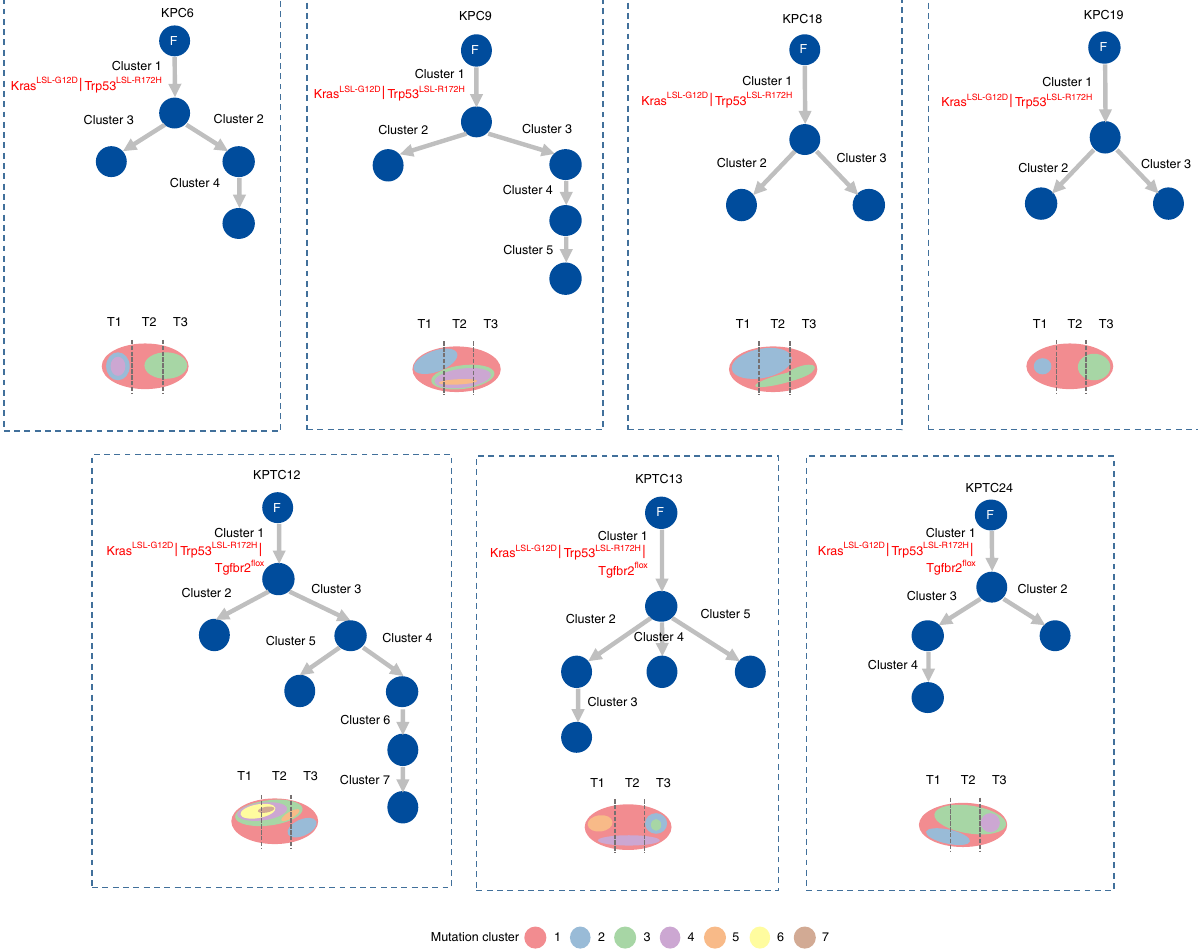
Fig. 5 Branched tumor phylogeny in KPC/KPTC mice. Seven mice had mutation cluster cancer cell prevalence values compatible with a branched evolutionary pattern. For mice KPC6 , KPC9 , KPTC13 , no mutation cluster appeared at high frequency in all three tumor regions, suggesting two synchronous primary tumors arose in these mice. A mutation cluster consisting of the knock-in tumor initiating mutations was added manually to represent the common ancestral cell. Similar to Fig. 4, a schematic diagram summarizing hierarchical order of subclones is shown for each case.